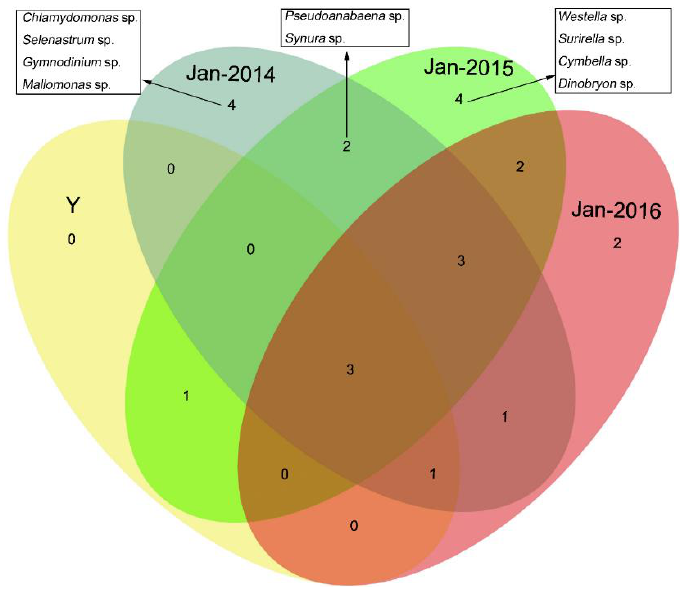
Figure 4. The Venn diagram showing numbers of the common and unique genera among water samples of the Yangtze River and the Wangyu River during different sampling times. Y: All of the samples collected from the Yangtze River; January-2014, January-2015, and January-2016: All samples from the Wangyu River on 12 January 2014, 16 January 2015, and 19 January 2016, respectively. The genera names in the box correspond to the unique genera only found in the Wangyu River during water diversion periods.